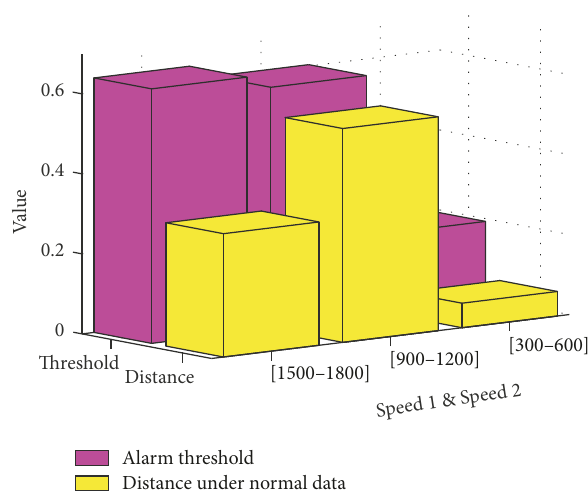
Figure 13: Alarm results for the normal data of the dual-rotor test rig.